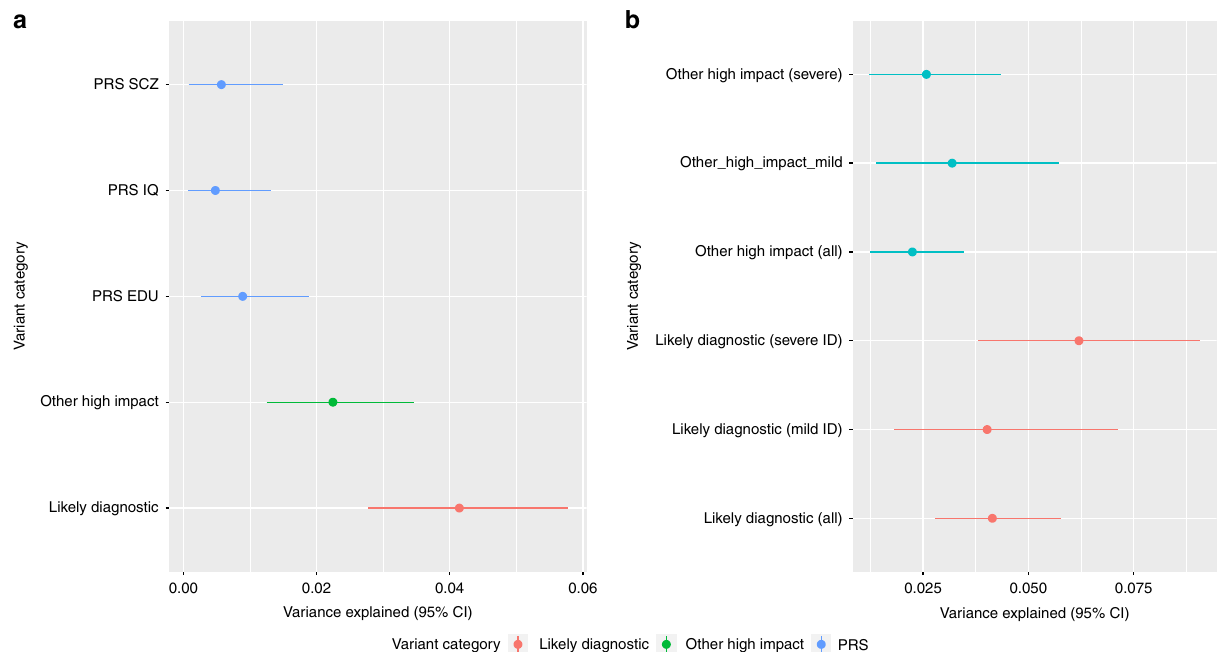
Fig. 7 Estimate of heritability explained by different variant categories on liability scale. a Variance explained by genetic categories in all ID cases. b Variance explained delineated by ID severity. Variance explained was estimated by Nagelkerke r2 while controlling for the fi rst four PCs. 95% Con fi dence intervals of variance explained were estimated by 5000 bootstrap samples. Source data are provided as a Source Data fi